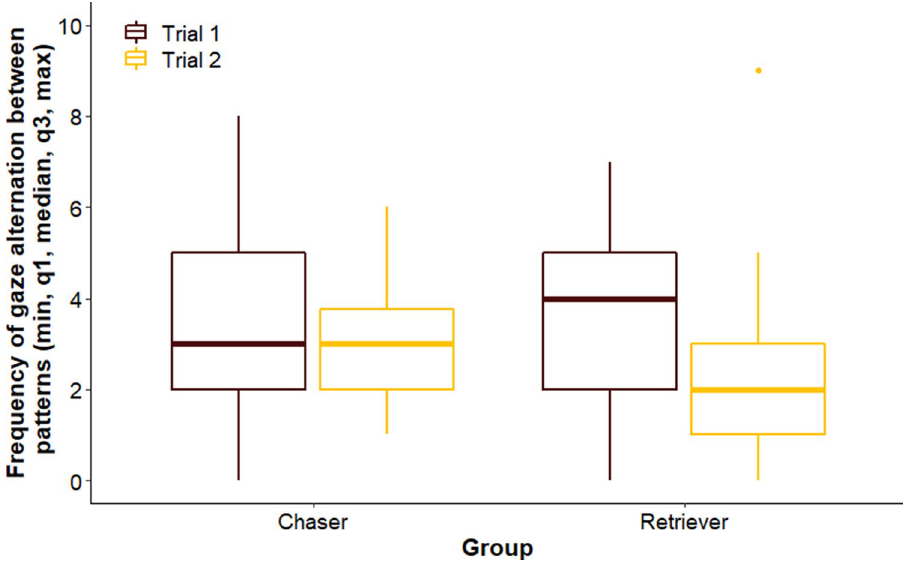
Figure 4. Frequency of gaze alternation of dogs in the different